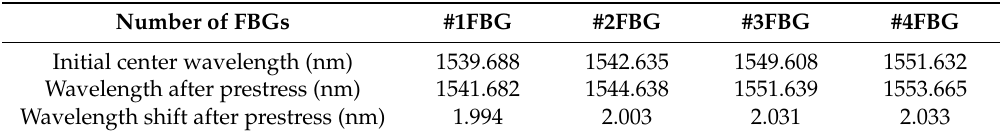
Figure 6. Schematic diagram of the pre-strain loading device of the sensor’s fiber Bragg gratings (FBGs). Table 1. Center wavelength shift of each fiber Bragg grating (FBG) of the sensor.